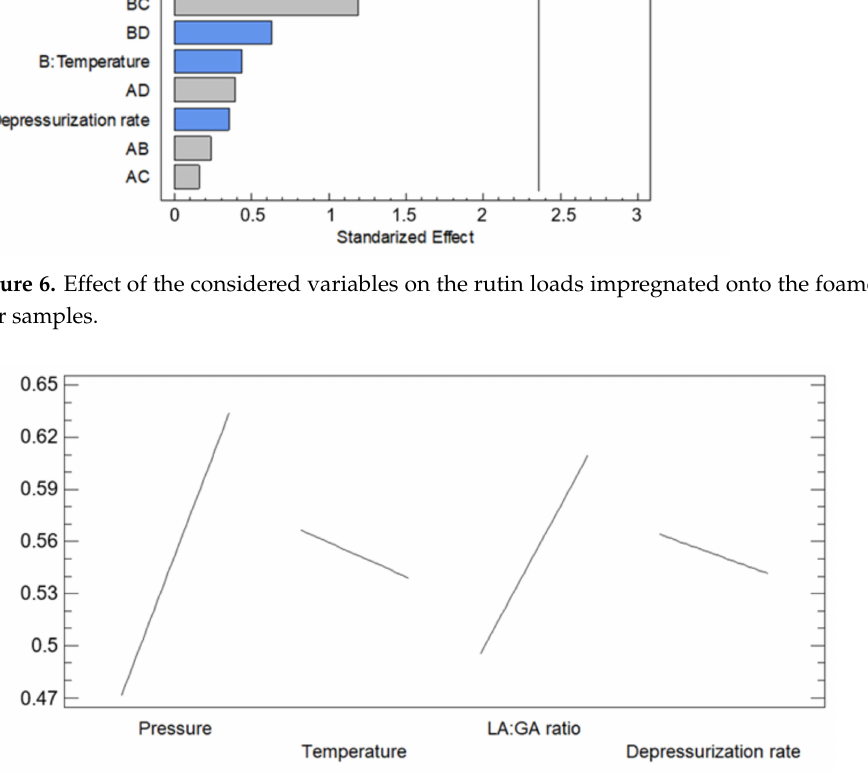
Figure 7. Main effects of the considered variables on the rutin loads impregnated onto the foamed polymer samples.